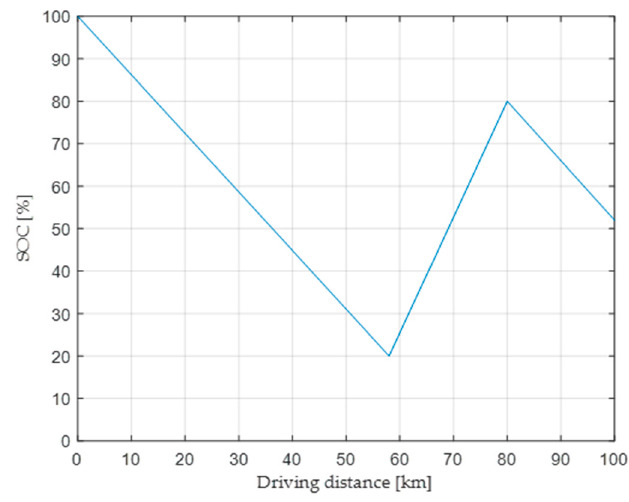
Figure 6. Battery volume of the electric vehicle, distance = 100 km.